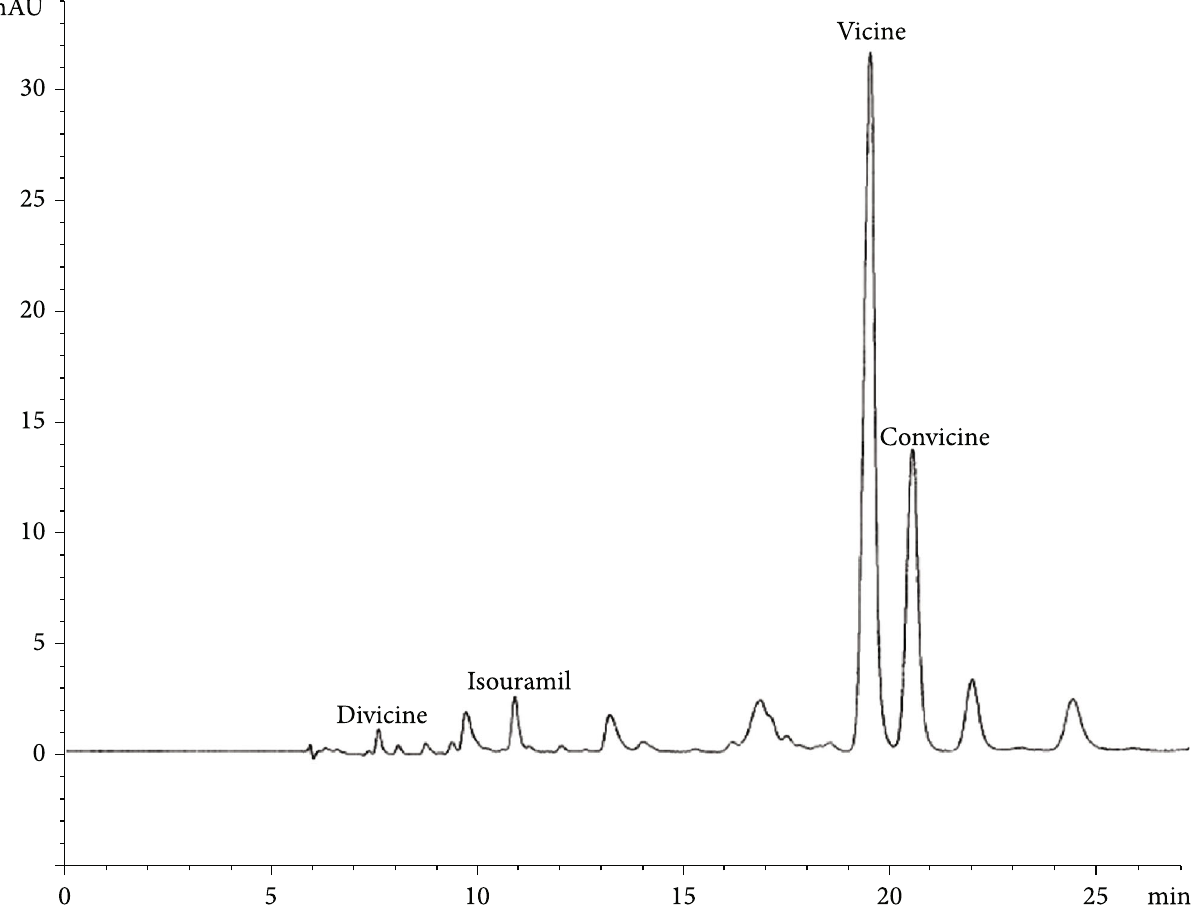
Figure 1: LC/UV chromatogram of a commercial fava bean protein isolate, showing the pyrimidine aglycones divicine and isouramil, and the pyrimidine glycosides vicine and